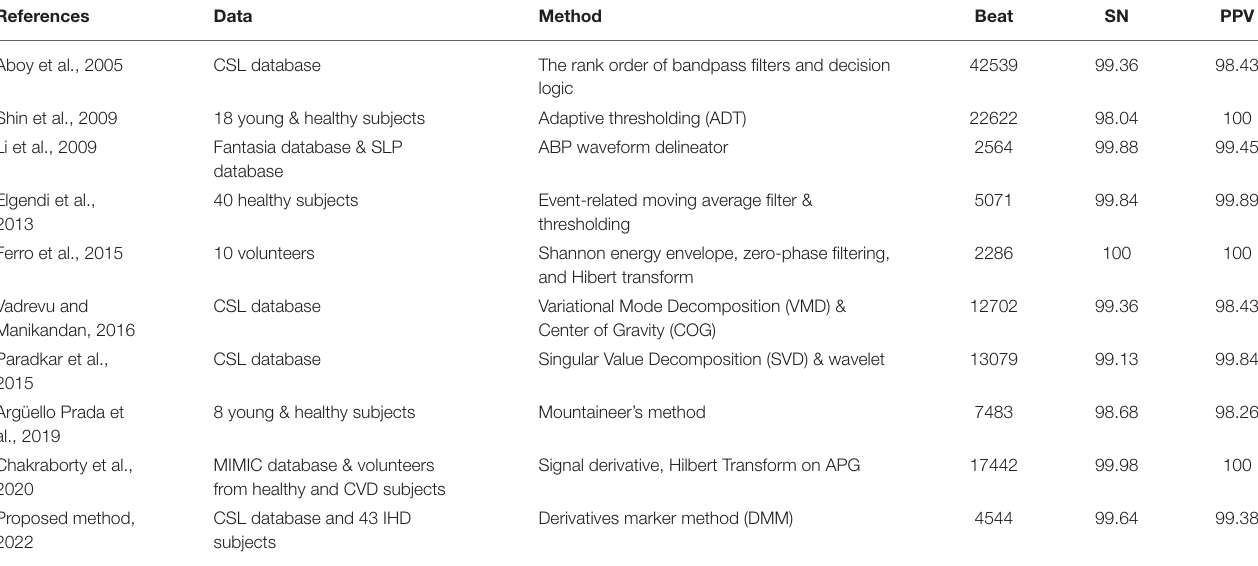
TABLE 4 | Comparison of systolic peak detection of DMM with other existing